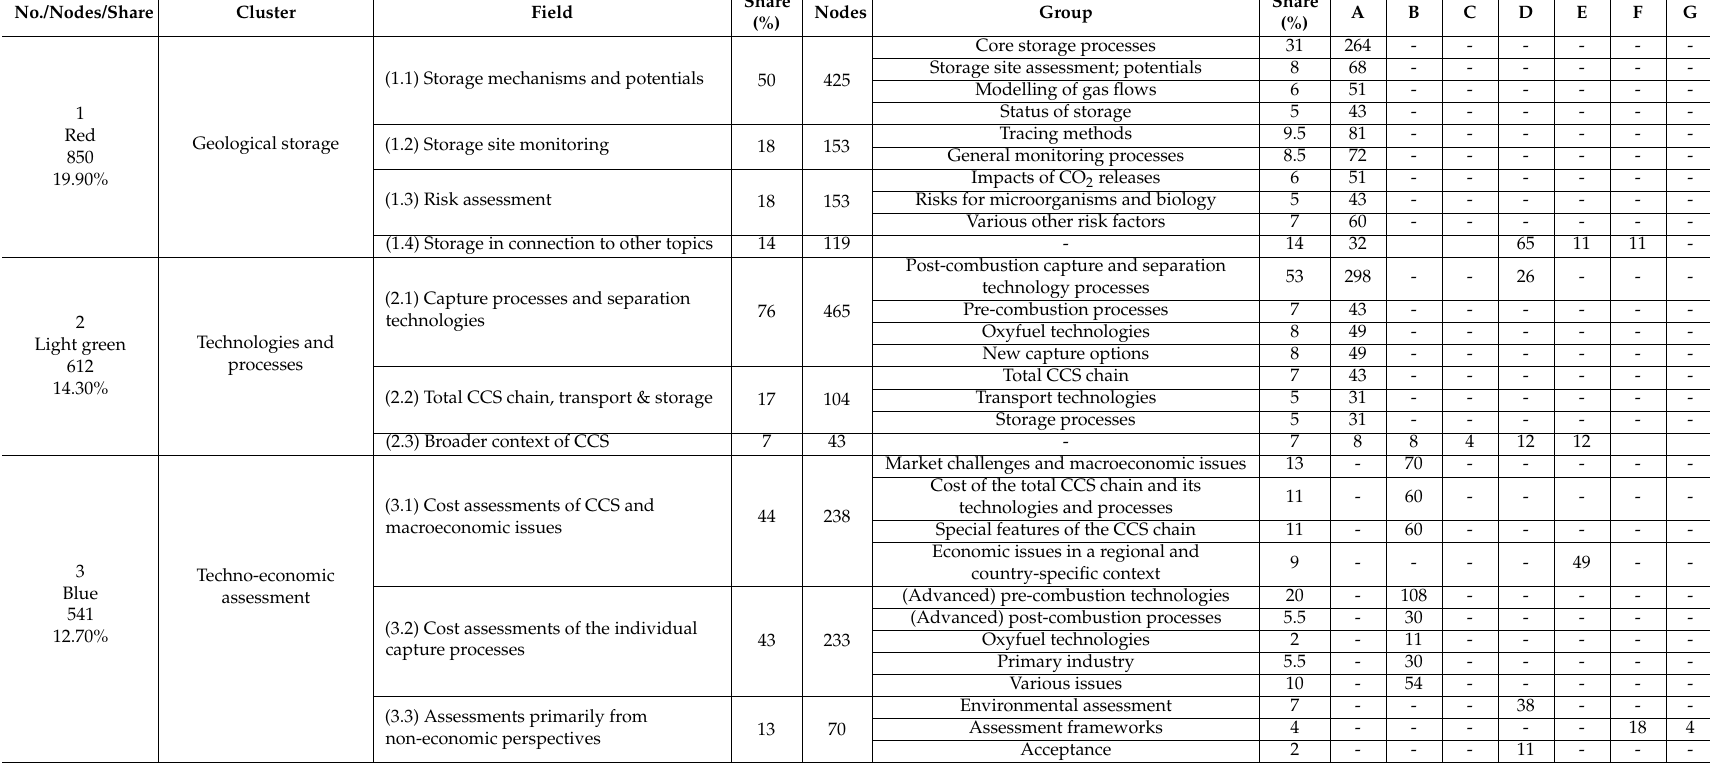
Table A2. Detailed description of the clusters, their fields and their groups. A = Technologies & technology assessments & technology modelling, B = Techno-economic assessments, C = Techno-economic modelling, D = Other assessment dimensions E = CCS in a broader context, F = Frameworks & integrated assessments, G = Energy